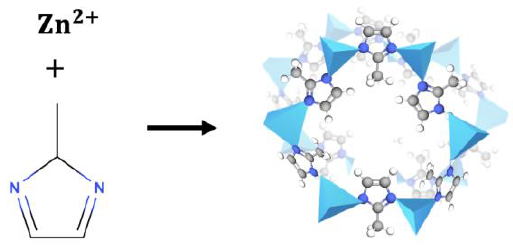
Figure 2. Schematic representation of the structure of ZIF-8.